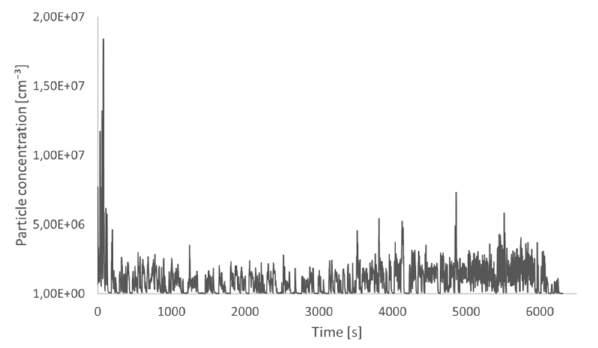
Fig. 6. Particle concentration during a 2-hour real driving (RDE) test with a GDI vehicle with no GPF installed